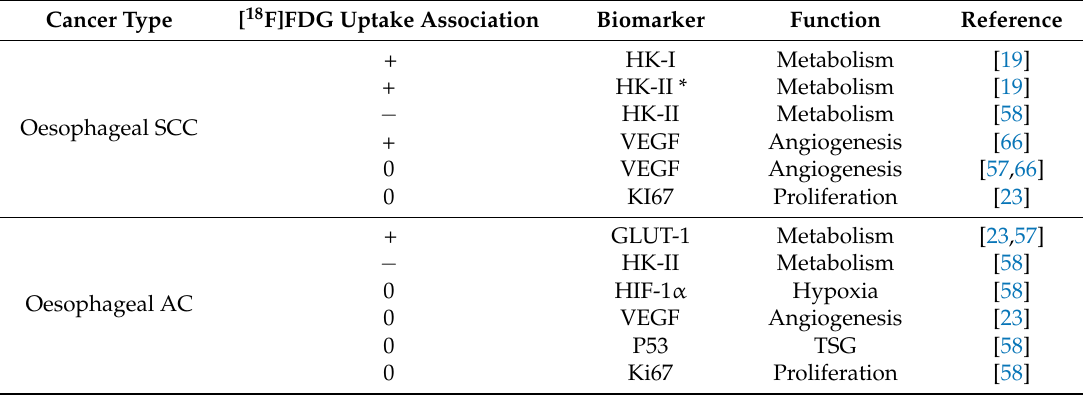
Table 2. Metabolic, hypoxic and angiogenic biomarkers affecting [ 18 F]FDG uptake in different cancer types. A positive association (+) indicates [ 18 F]FDG uptake increased with biomarker. A negative association ( − ) indicates [ 18 F]FDG uptake decreased with biomarker. A null association (0)